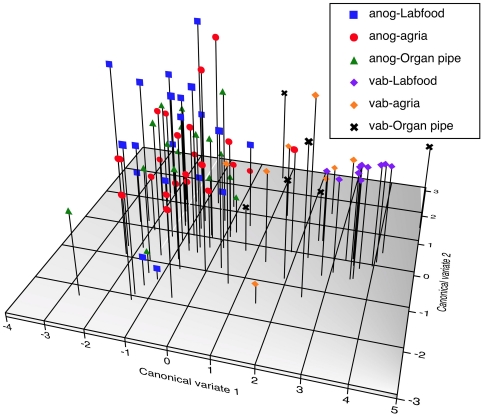
Canonical Discriminant Function plot showing the effects of larval diet on adult CHC expression.Male anogenital (anog) and ventral abdomen (vab) CHC variation in D. mojavensis vary depending on whether the larvae were reared on lab food, agria cactus, and organ pipe cactus.